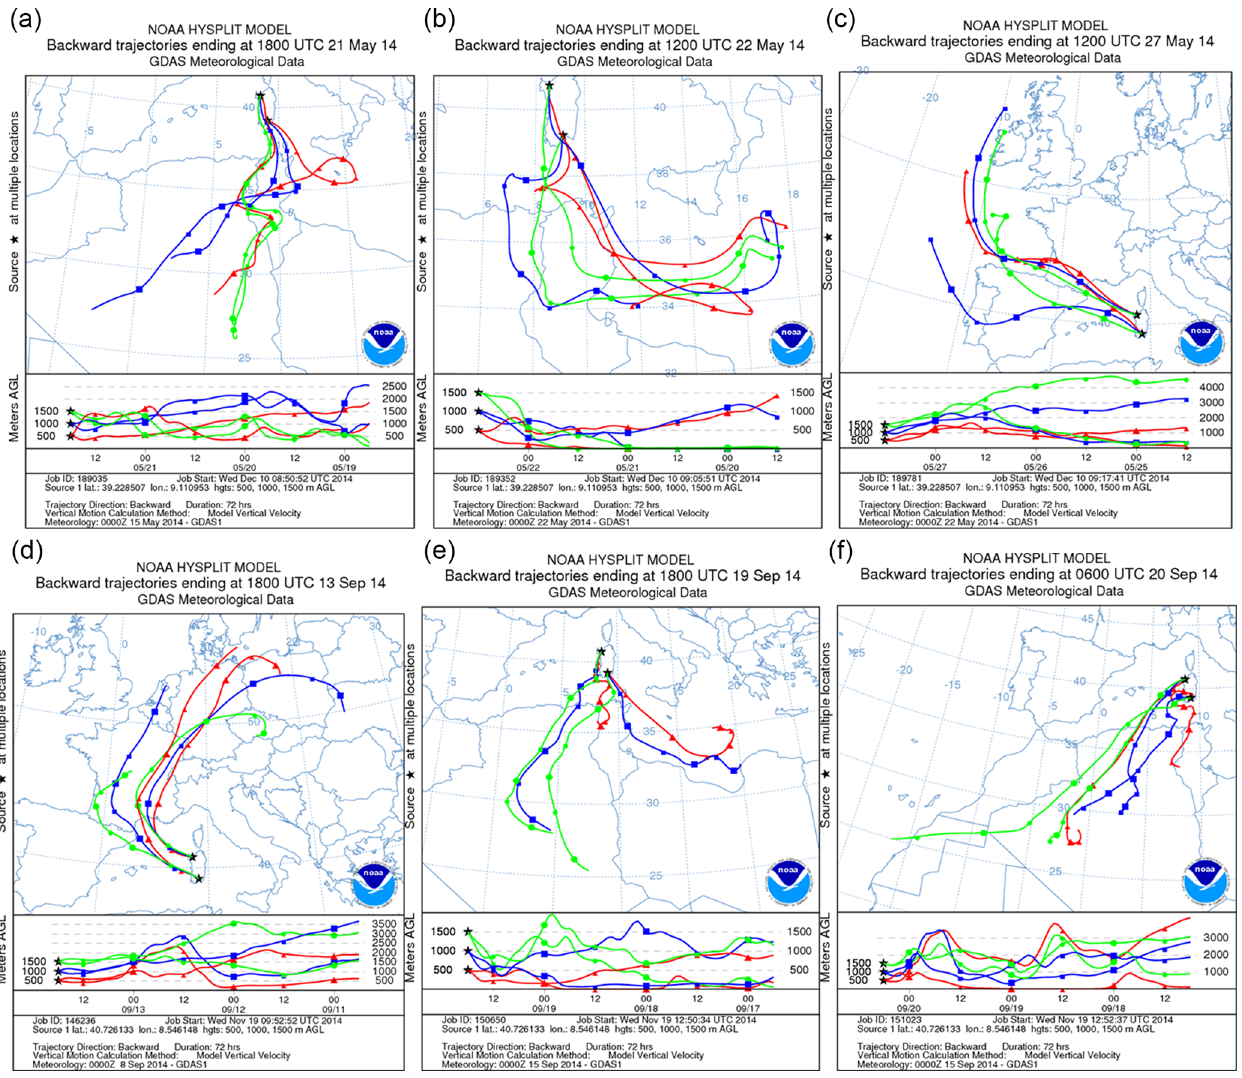
Figure 2. (a–c) The 3d air mass backward trajectories calculated by the NOAA HYSPLIT model ending at 18:00UTC 21 May, 12:00UTC 22 May, and 12:00UTC 27 May 2014 at both sampling sites. (d–f) The 3d air mass backward trajectories calculated as above, ending at 18:00UTC 13 September, 18:00UTC 19 September, and 06:00UTC 20 September 2014 at both sampling sites (credit to https://www.ready.